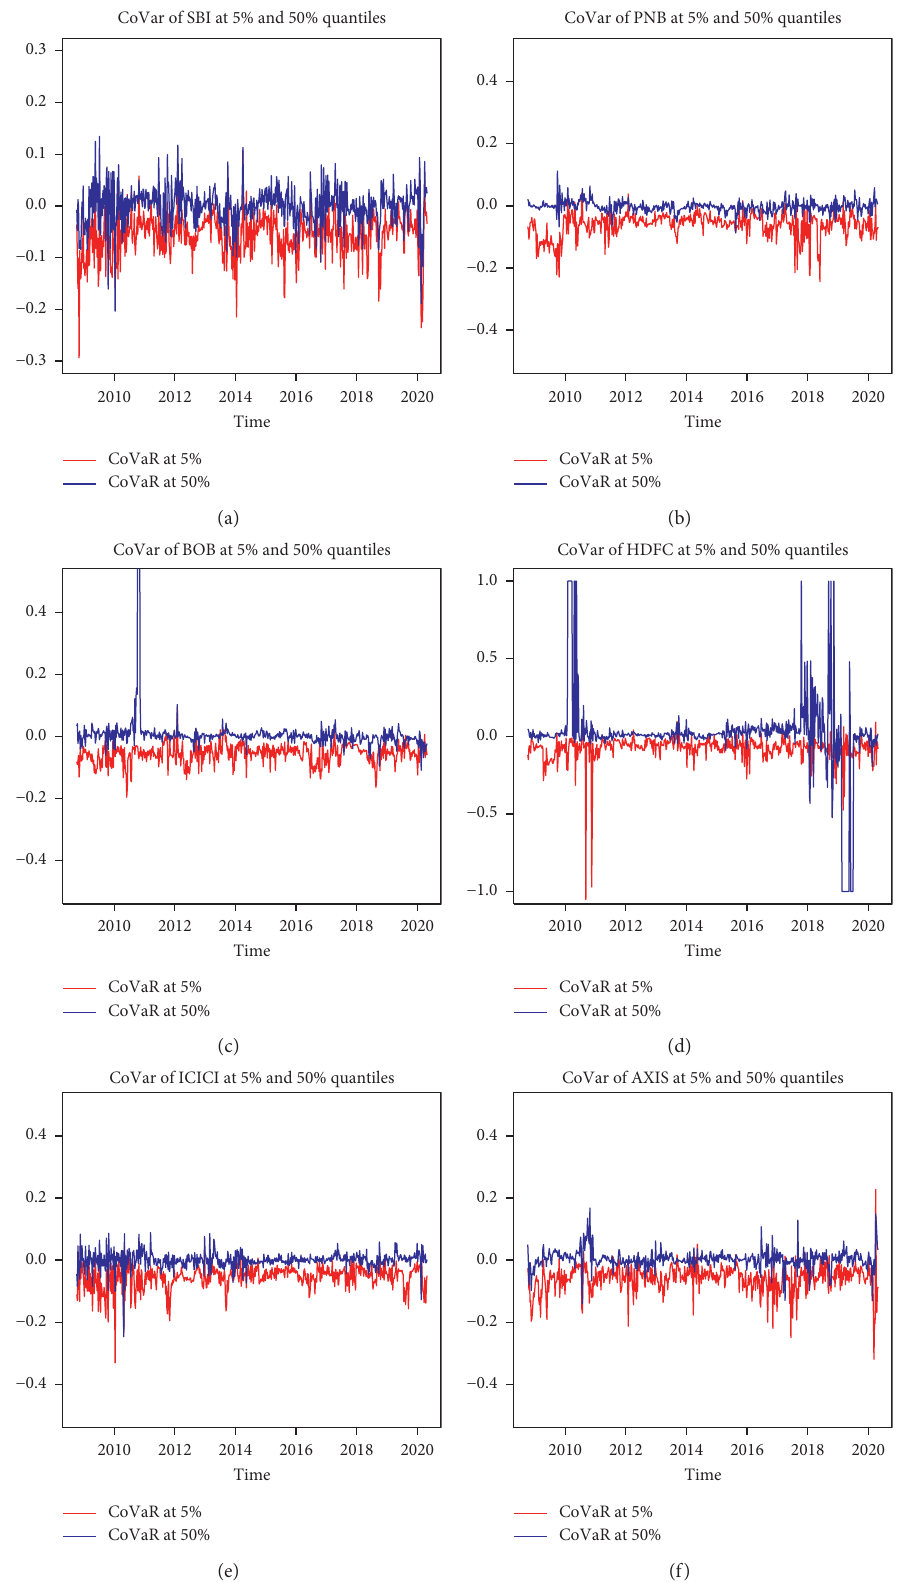
Figure 2: (a) CoVar of SBI at 5% and 50% quantiles. (b) CoVar of PNB at 5% and 50% quantiles. (c) CoVar of BOB at 5% and 50% quantiles. (d) CoVar of HDFC at 5% and 50% quantiles. (e) CoVar of ICICI at 5% and 50% quantiles. (f) CoVar of AXIS at 5% and 50%